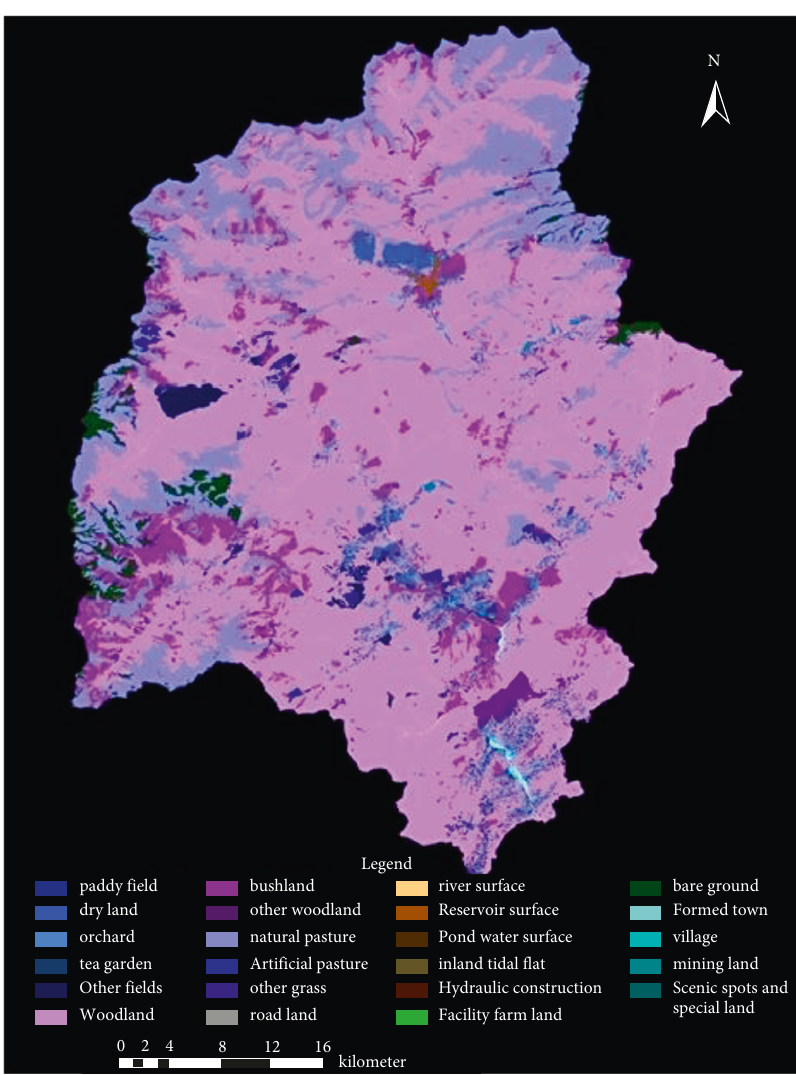
Figure 8: Schematic diagram of dynamic identification of land use